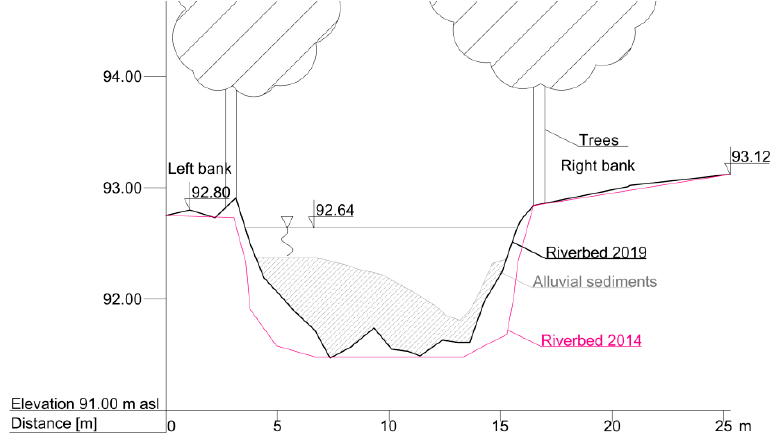
Figure 4. Bed changes in cross-section no. 2 (in a forested area).